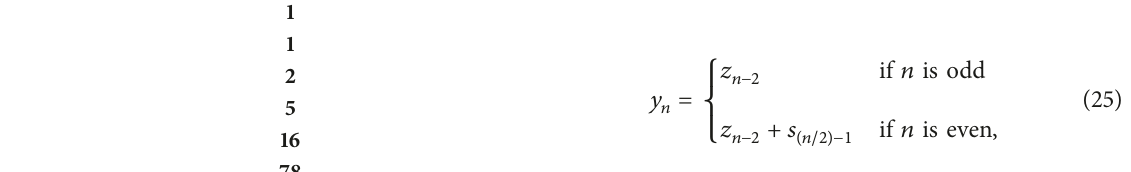
Table 1: Number of graphs without (true) twin vertices. Order ( 𝑛 )